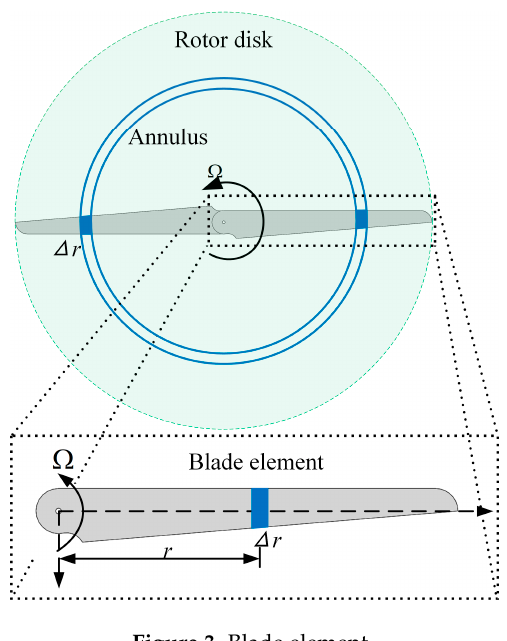
Figure 3. Blade element.